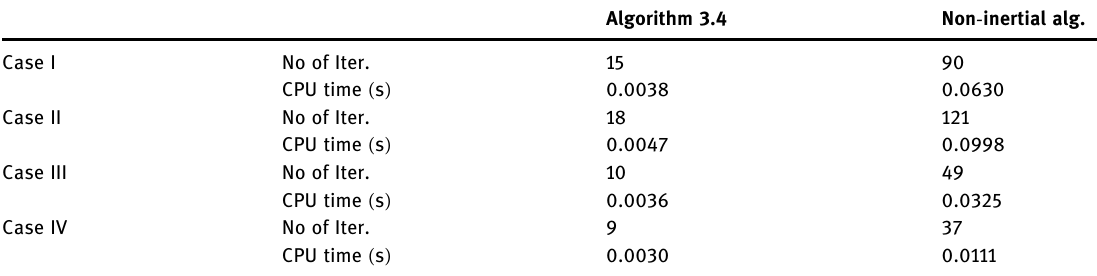
Table 1: Computation result for Example